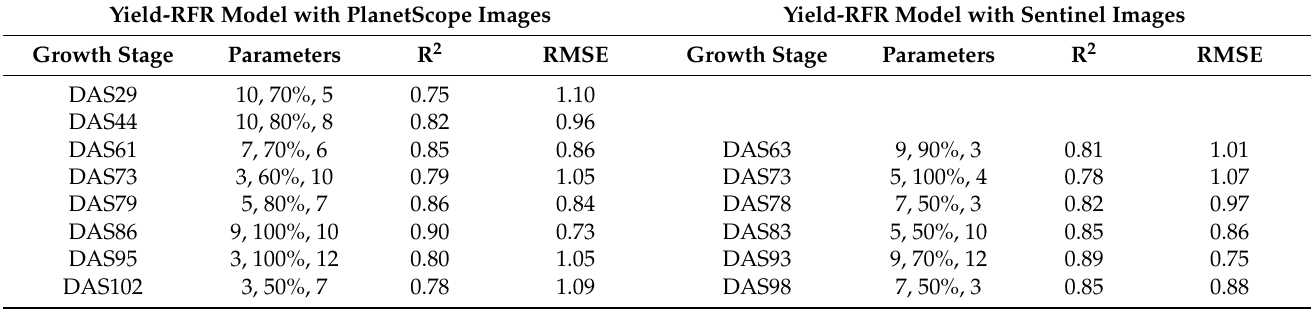
Table 6. The Yield-RFR model constructed with PlanetScope and Sentinel images (Parameters represented the n-estimations, max-features, and depth in